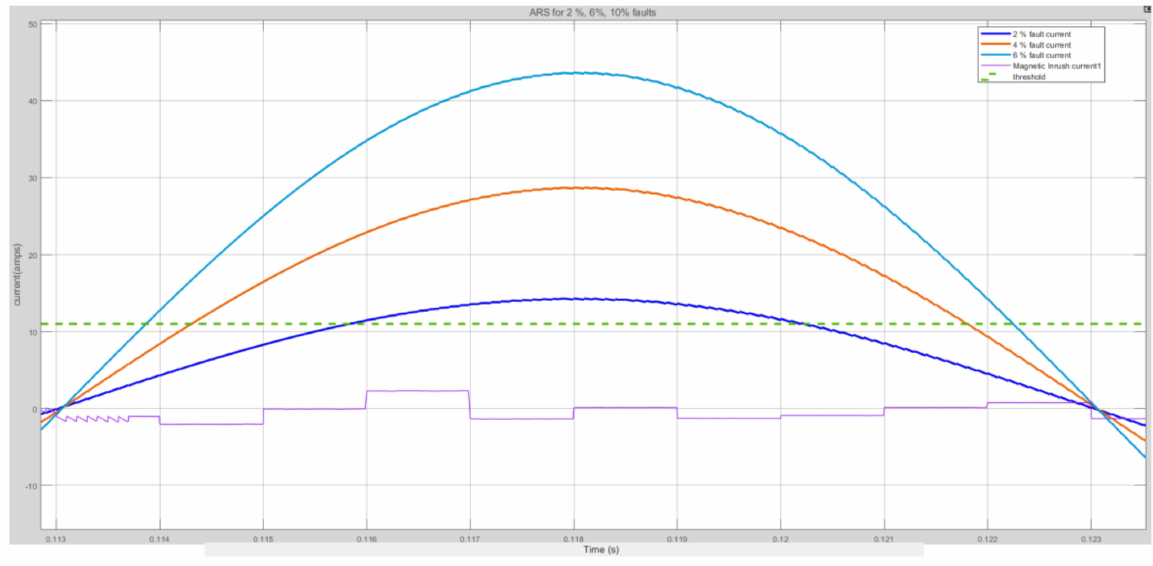
Figure 20. ARS signals for various